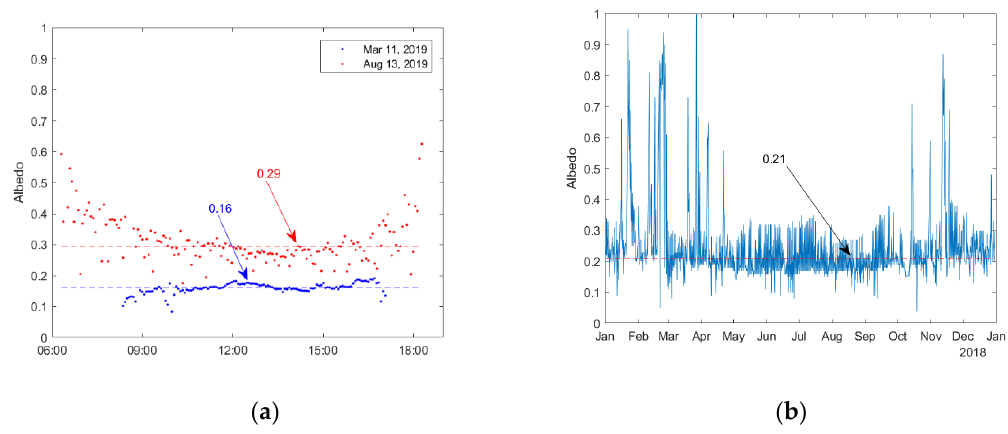
Figure 3. Albedo measurements. ( a ) Two representative days at the ground station in Murcia in winter and summer season, together with median values for each day, 5-min time steps records; ( b ) Full-year at NREL laboratories, together with median value of 0.21, hourly-average values.